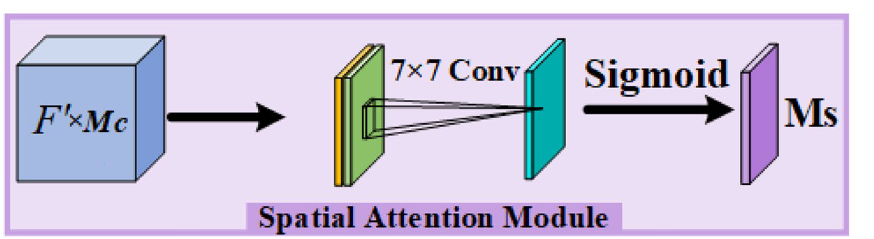
Figure 9. Channel attention module.